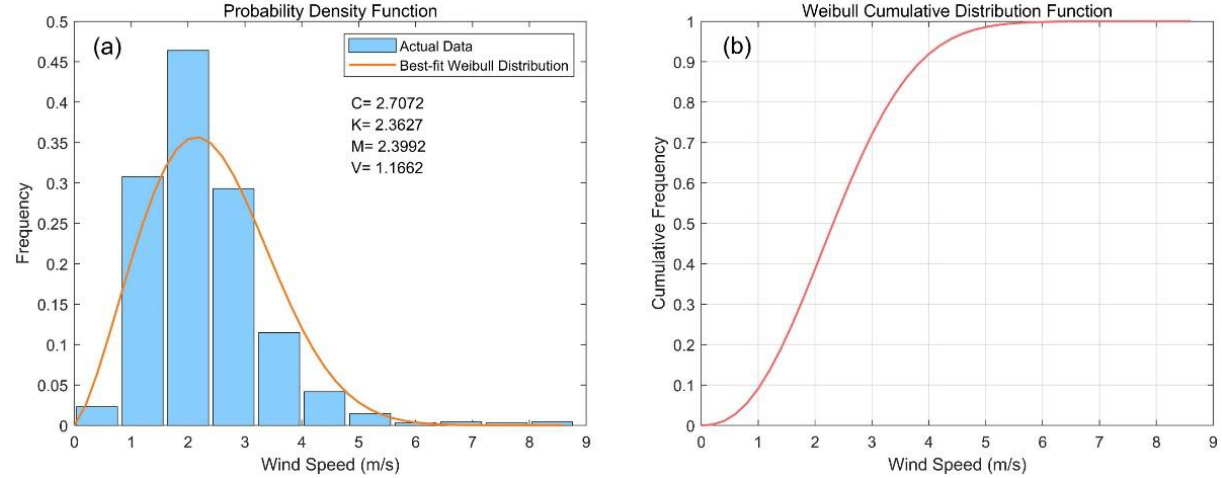
Figure 6. ( a ) The wind speed range of meteorological sites and Weibull probability density function; ( b ) the cumulative distribution function.